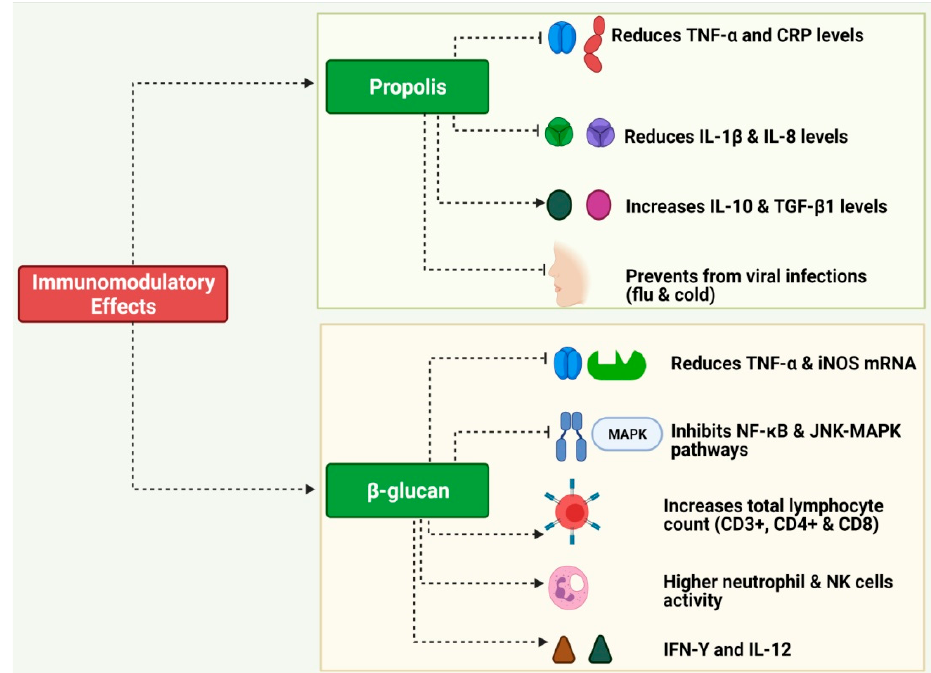
Figure 3. Immunomodulatory activities of propolis and β -glucans.